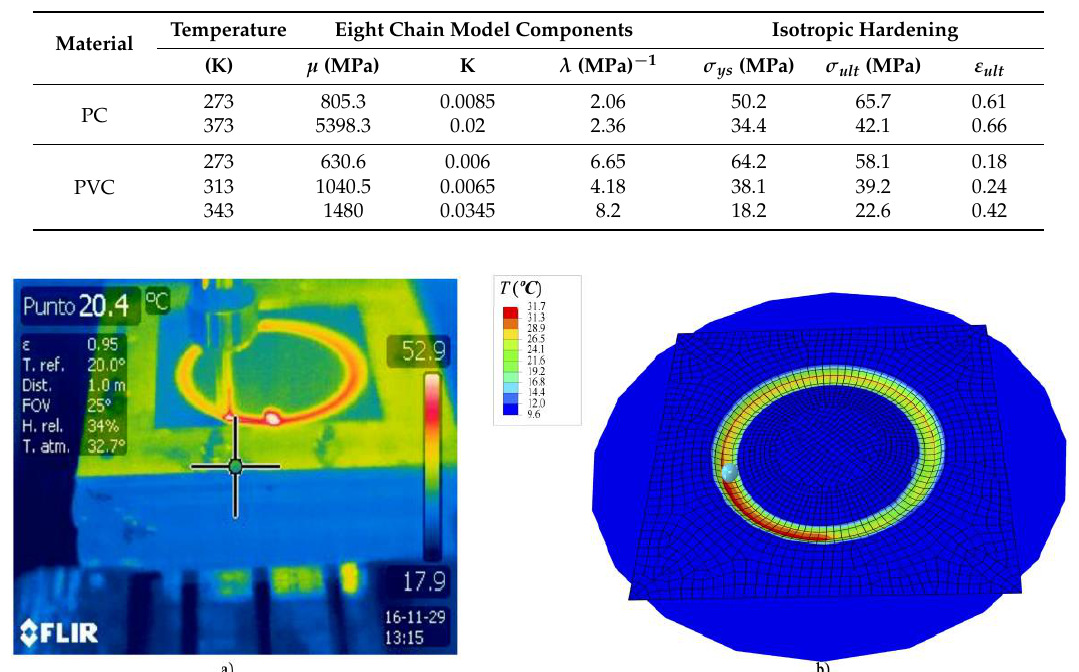
Figure 6. Temperature for a PVC sheet: ( a ) Example of experimental temperature measurements; ( b ) numerical temperature estimation.